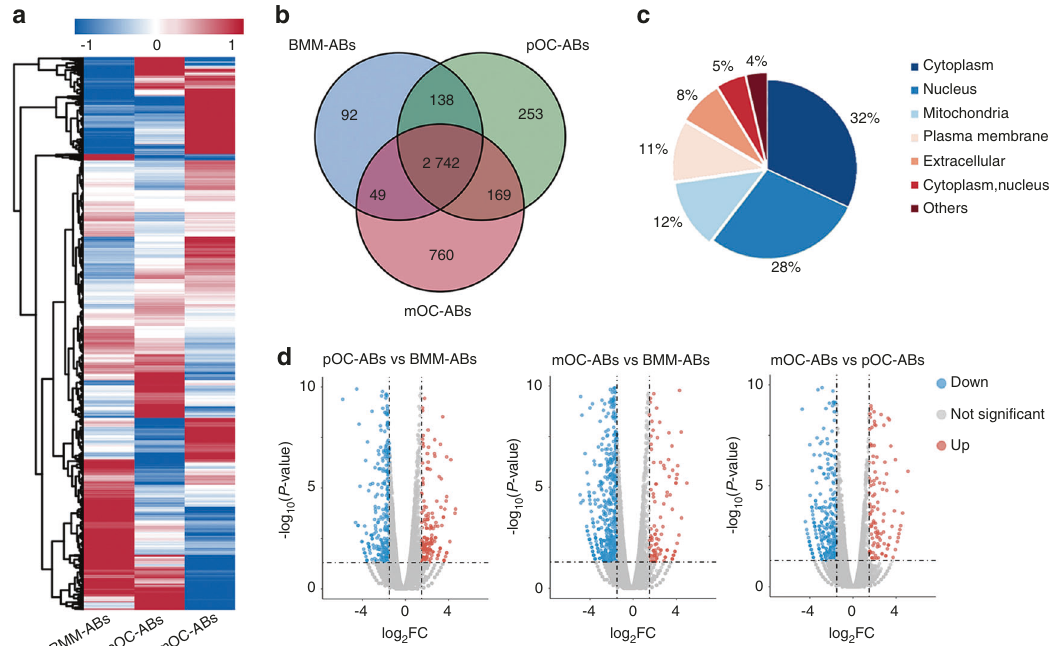
Fig. 2 Proteomic pro fi ling of ABs from BMMs, pOCs, and mOCs. a Heat map visualization of hierarchical clustering showing the expression pro fi le of 4 306 proteins identi fi ed in ABs. b Venn diagrams comparing the total proteomes of different types of ABs. c Subcellular localization analysis showing the intracellular distribution of all DEPs. The DEPs were localized mainly in the cytoplasm, nucleus, and mitochondria. d Volcano plots showing the DEPs in the three comparison groups. The red dots represent DUPs (FC > 2.0), and the blue dots represent DDPs (FC <